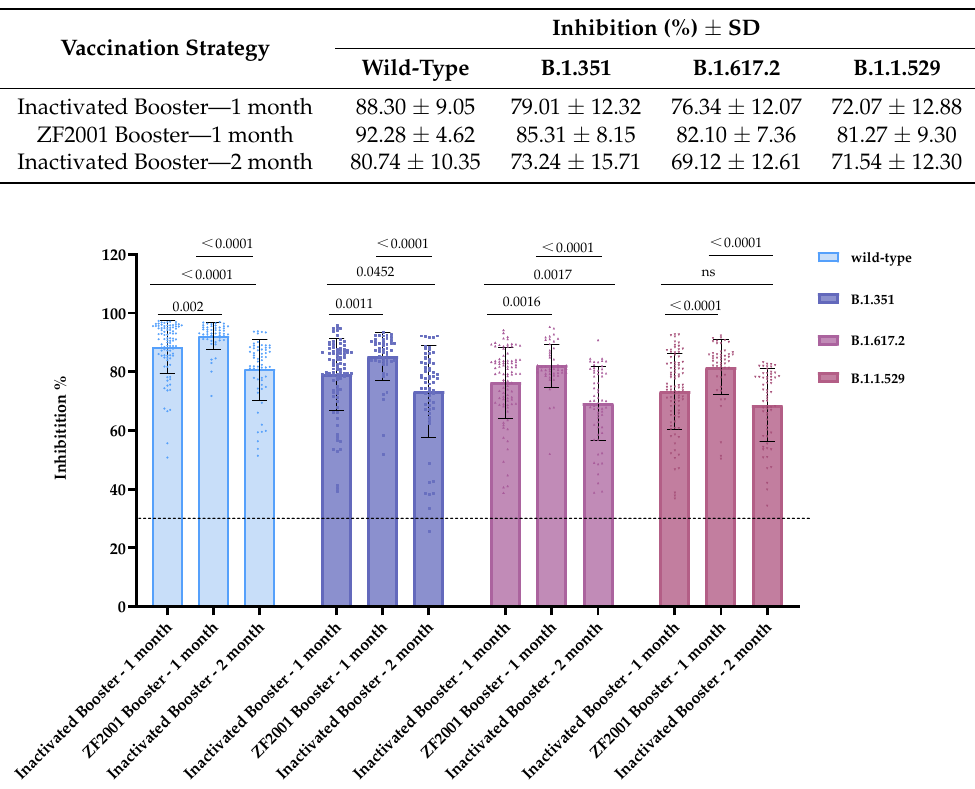
Figure 5. Comparison between the antibody inhibition rates of homologous and heterologous boosters against wild-type, B.1.351, B.1.617.2, and B.1.1.529. The dotted lines represent the cutoff at 30% inhibition. ns: no significance. Table 3. The post-booster average inhibition rates against wild-type, B.1.351, B.1.617.2 and B.1.1.529 mutant strains.